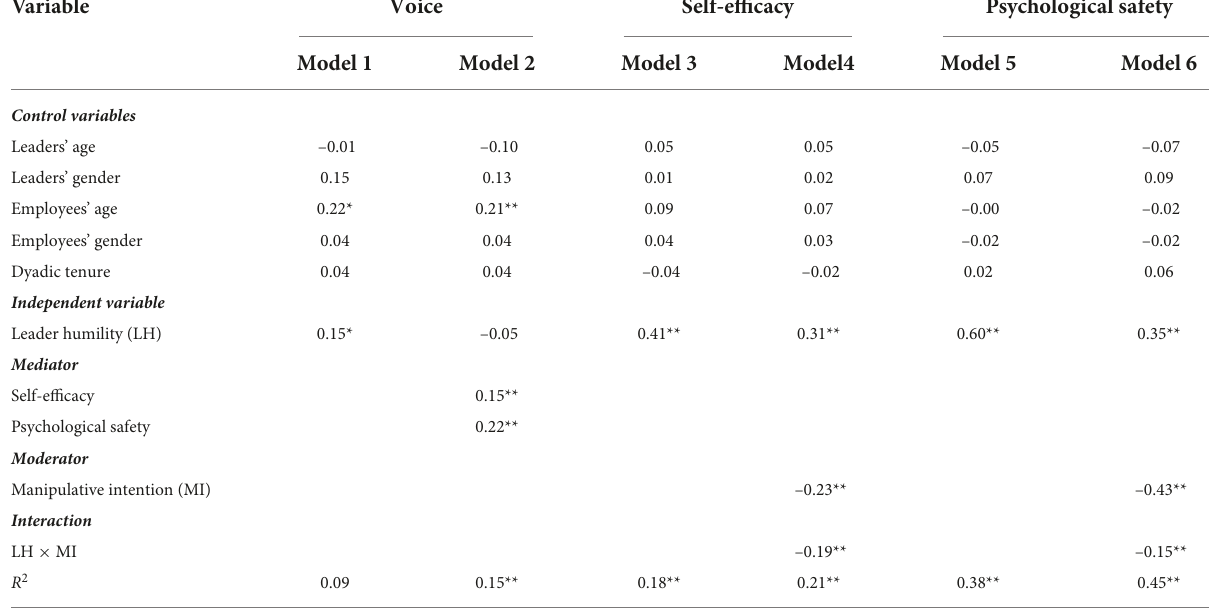
TABLE 4 Results of hierarchal